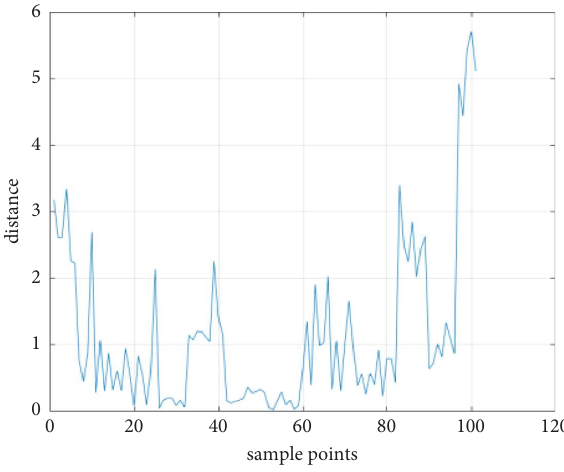
Figure 1: Mahalanobis